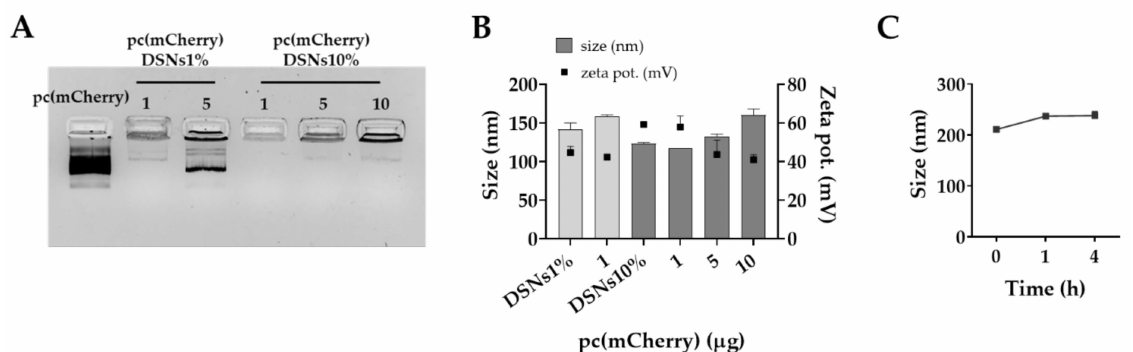
Figure 1. Association of pc(mCherry) to DSNs. ( A ) Association of pc(mCherry) (1 to 10 µ g) to DSNs, prepared with 1% or 10% of DOTAP (DSNs1% and DSNs10%), determined by agarose gel electrophoresis. ( B ) Physicochemical properties of DSNs1% associating 1 µ g of pc(mCherry) and DSNs10% associating 1, 5 and 10 µ g of pc(mCherry). ( C ) Colloidal stability of DSNs10% associating 10 µ g of pc(mCherry) in 1% FBS-supplemented DMEM, up to 4 h. (nm, nanometers; PdI, polydispersity index; zeta pot., zeta potential; mV